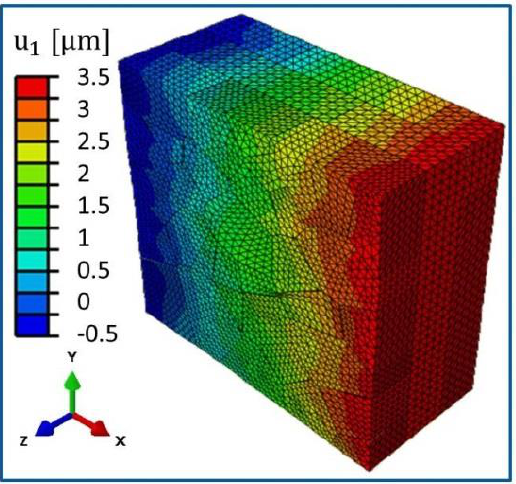
Figure 4. Illustration of the displacement in x − axis at 6% strain in x − direction.